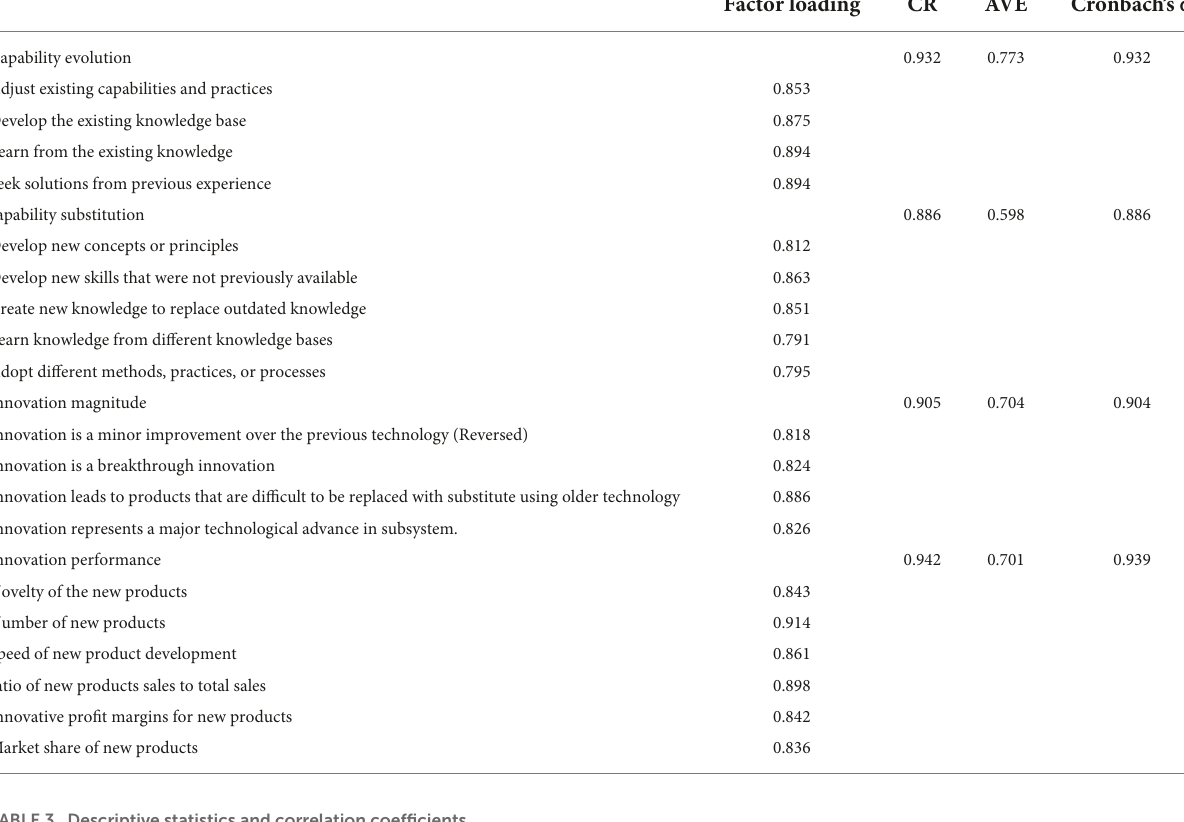
TABLE 2 Measurement scales.